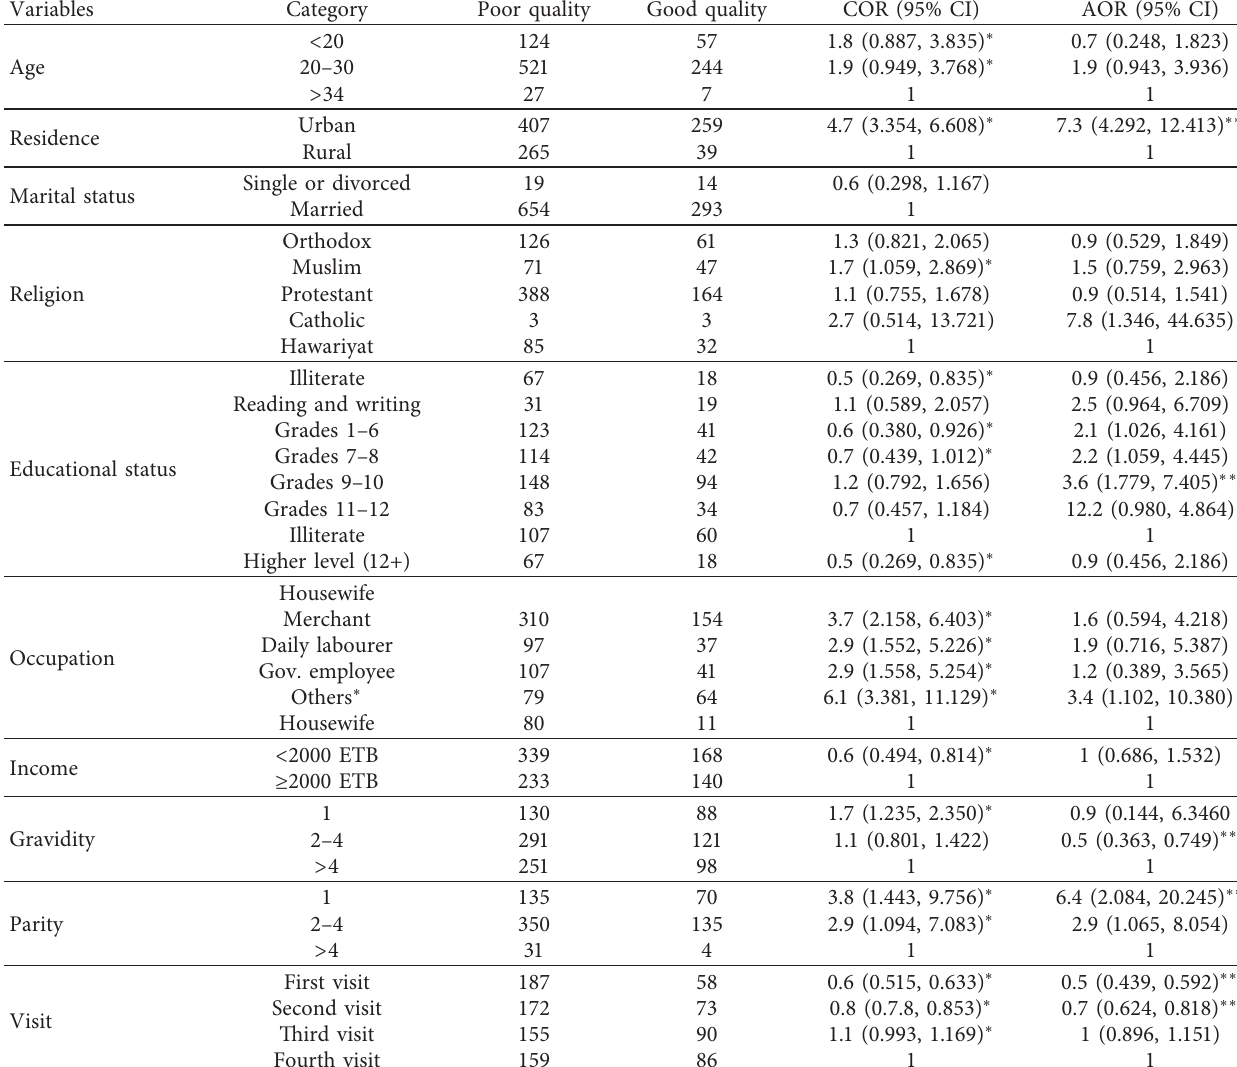
Table 2: Generalized estimating equation logistic regression to identify determinants of quality of ANC among pregnant women